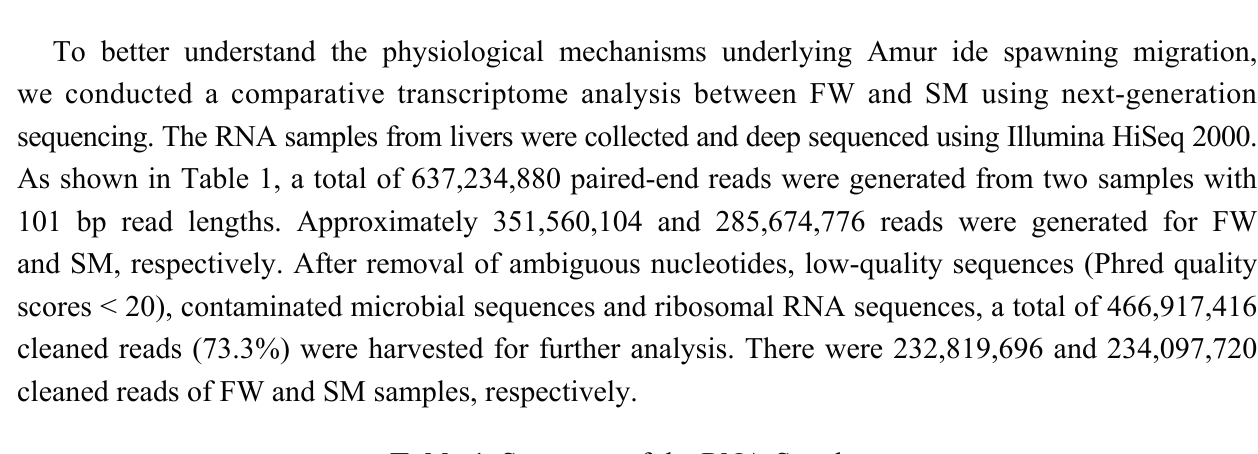
Table 1. Summary of the RNA-Seq